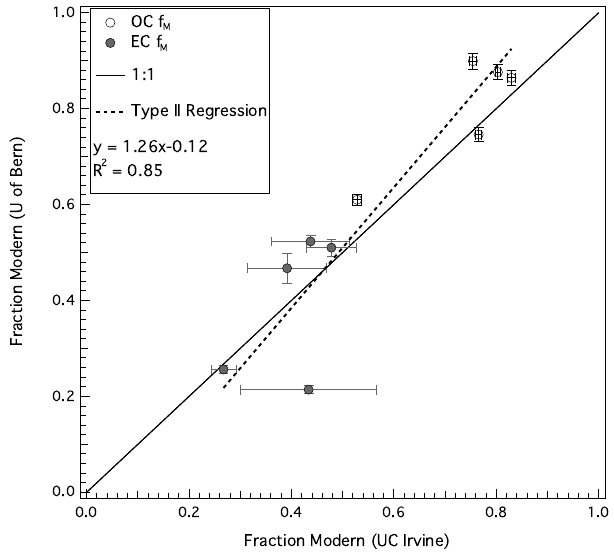
Figure 4. Intercomparison between 14 C measurements of OC and EC on five PM 2 . 5 filters, measured at the University of Bern and the University of California,